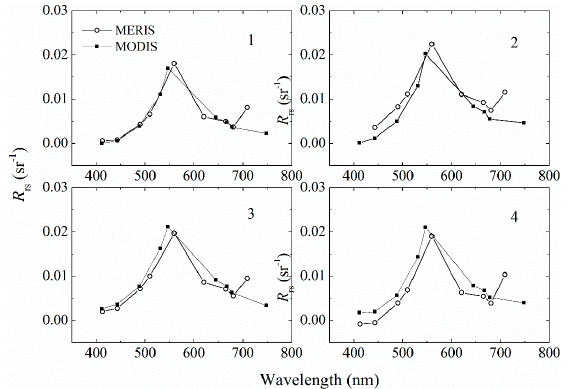
Figure 12. The R rs ( λ ) from MODIS and MERIS imagery at the same locations. The 1, 2, 3, and 4 correspond to the locations marked in Figure 11A.